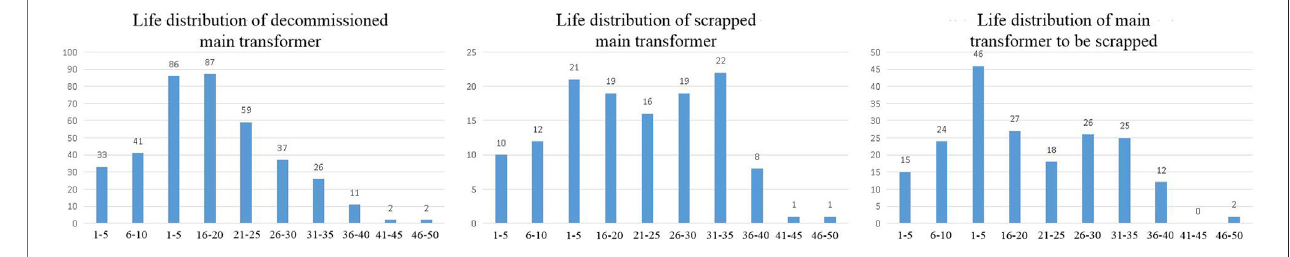
FIGURE 1 | Life distribution.